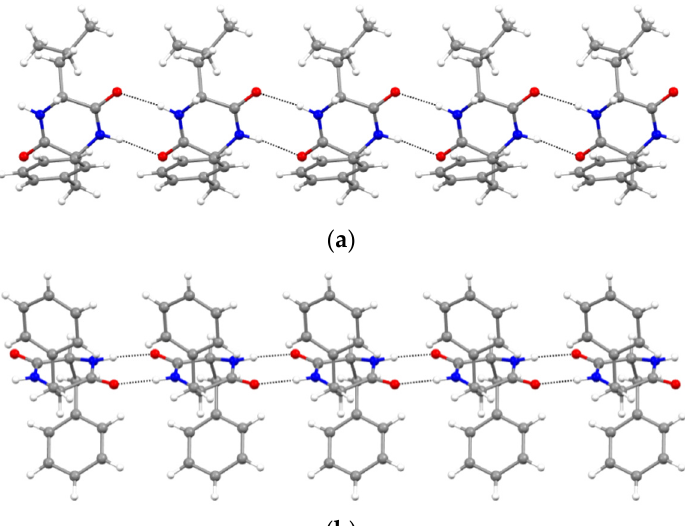
Figure 3 . NH···OC H-bonded (dashed lines) ribbons in ( a ) DKP2 (CCDC 2209459) and ( b ) DKP4 (CCDC 2209458). Oxygen atoms are shown in red, nitrogen atoms in blue, carbon atoms in grey, and hydrogen atoms in white.